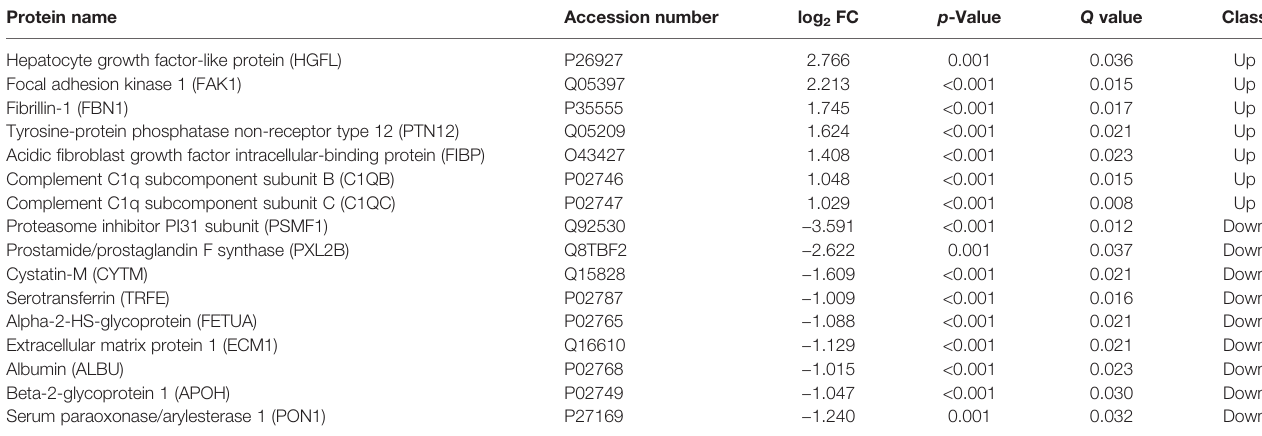
TABLE 3 | Statistics of differential proteins between patients with HT and healthy controls. Protein name